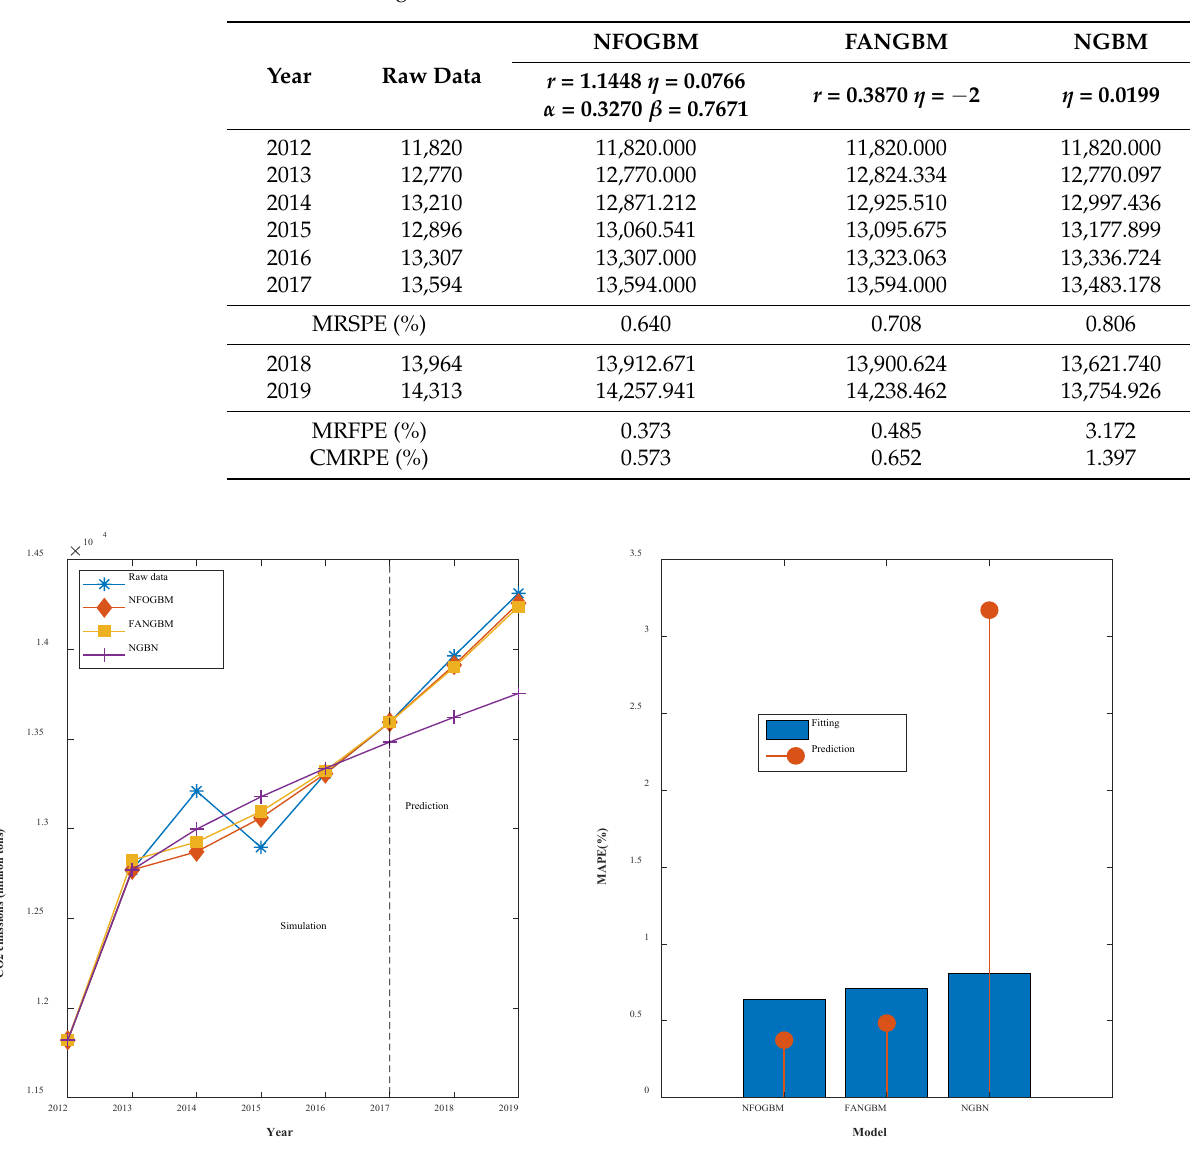
Table 8. Modeling results for PSESH.